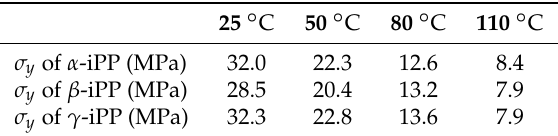
Table 2. Yield stresses obtained in the tensile